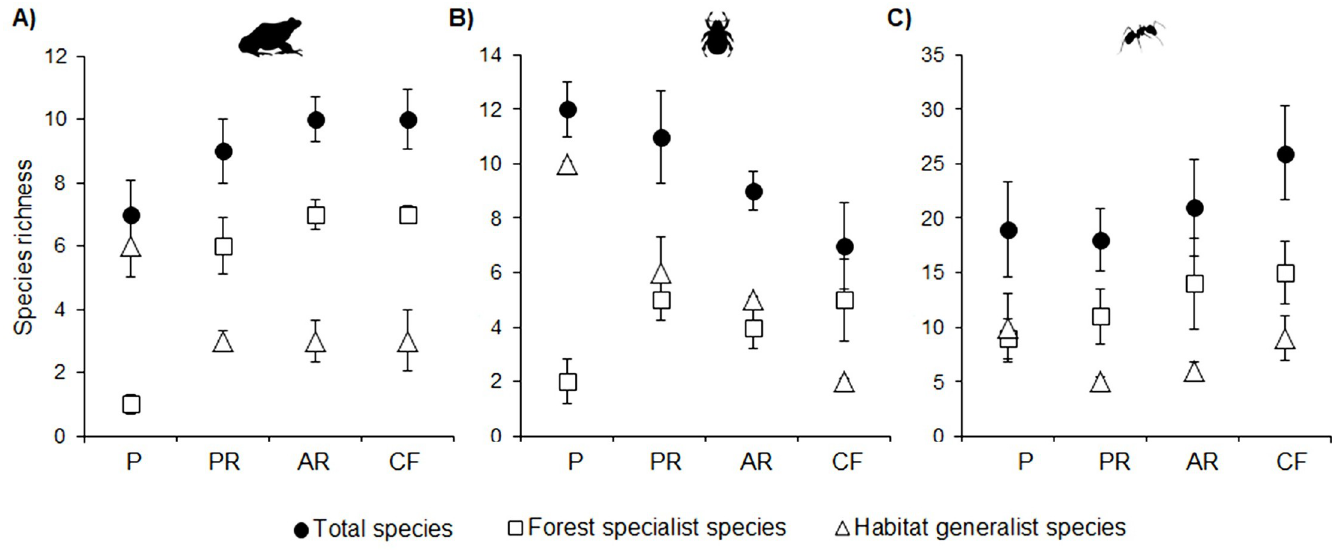
Fig 2. Species richness of amphibians (a), dung beetles (b) and ants (c) in four vegetation types. P = cattle pasture, PR = forest under passive restoration, AR = forest under active restoration and CF = mature cloud forest. Error bars denote 95% confidence intervals.